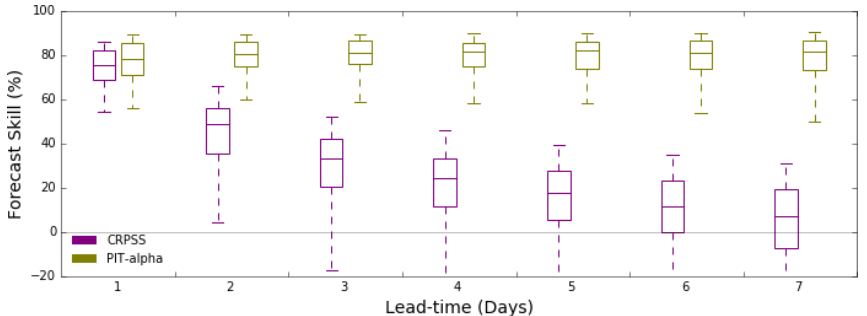
Figure 11. Forecast skill (CRPSS %) and reliability (PIT-alpha %) for the 209 forecast locations in the operational public service.